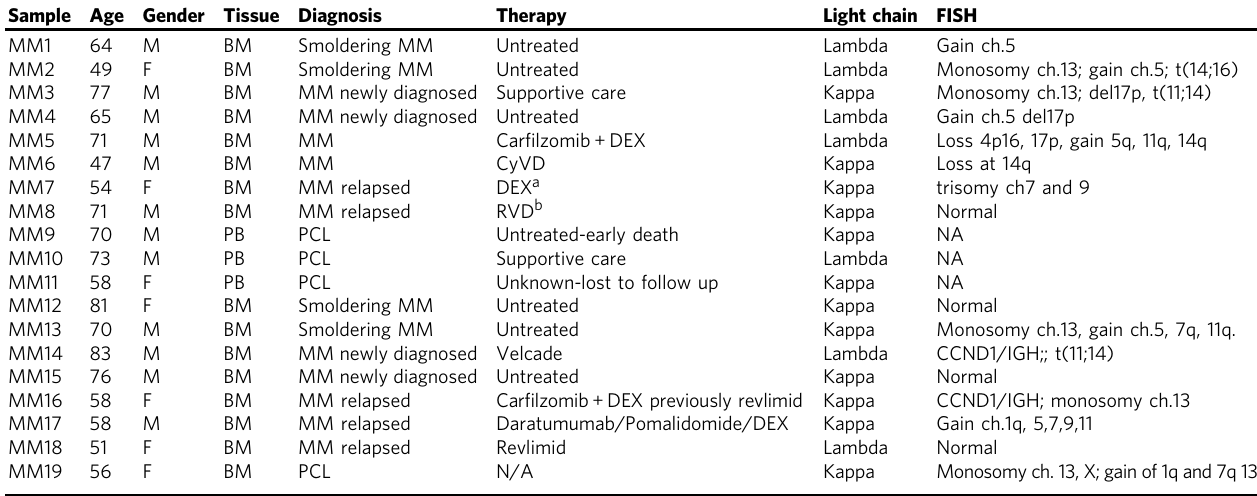
Table 1 Clinical information on primary samples used in this study Sample Age Gender Tissue